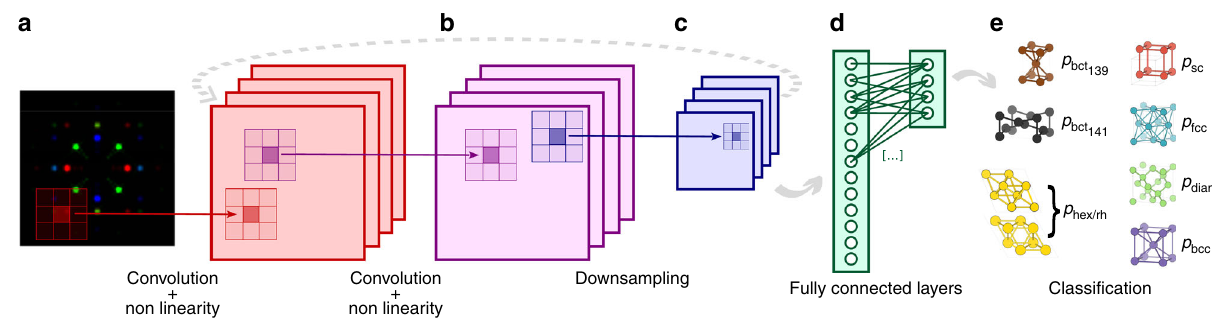
Fig. 3 Schematic representation of the convolutional neural network (ConvNet) used for crystals classi fi cation. a A learnable fi lter (also called kernel) is convolved across the image, and the scalar product between the fi lter and the input at every position is computed. This results in a two-dimensional activation map (in red) of that fi lter at each spatial position, which is then passed through a recti fi ed linear unit (ReLu) 66 . b The same procedure as point a is applied to this activation map (instead of the original image), producing another activation map (in purple). c A downsampling operation (in blue) is performed to coarse grain the representation. Six convolutional and two downsampling (max pooling) layers are stacked sequentially (see Methods for additional details). d The output of the convolutional/downsampling layers sequence is passed to fully connected layers (regularized using dropout 67 ) to complete the classi fi cation procedure. e The ConvNet outputs the probabilities that the input image, and therefore the corresponding material, belongs to a given class. Minimizing the classi fi cation error, the above-mentioned fi lters are learned — through backpropagation 68 — and they will activate when a similar feature (e.g., edges or curves for initial layers, and more complex motifs for deeper layers) appears in the